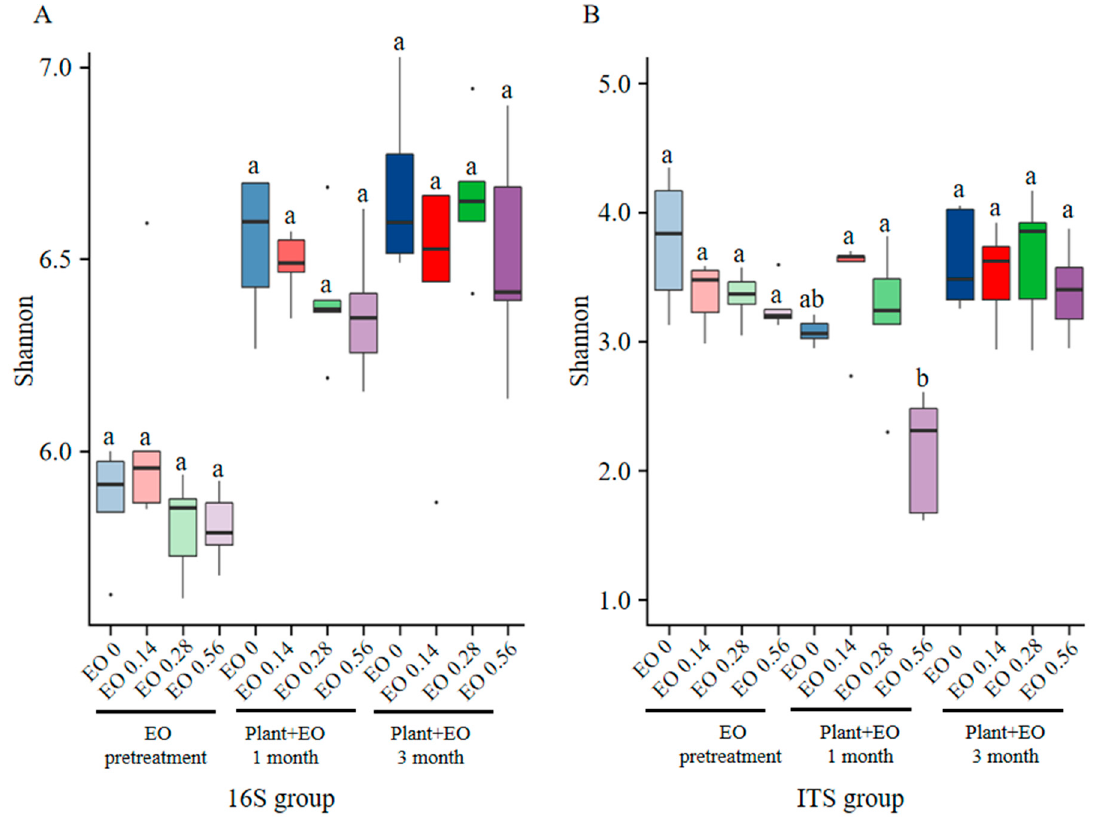
Figure 2. Box plots showing alpha diversity (Shannon index) variation across samples on 16S data ( A ) and ITS data ( B ). The concentrations of EO in the soil were 0 mg/g (control), 0.14 mg/g (low concentration), 0.28 mg/g (medium concentration), and 0.56 mg/g (high concentration). The three stages were: EO pretreatment for seven days, then P. notoginseng was planted and samples were assessed at one and three months. Different letters in each stage indicate statistically significant differences ( p < 0.05) according to ANOVA test. Dots represent samples that deviate from other biological replicates.